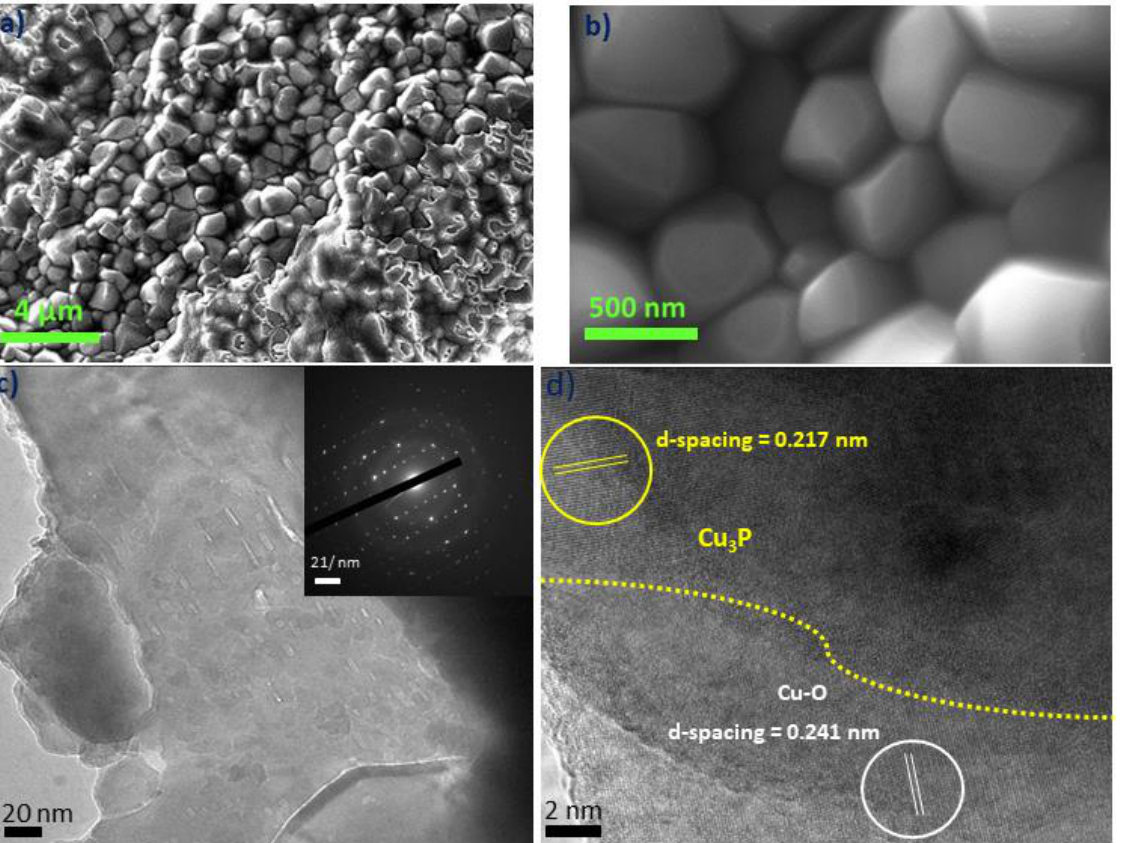
Figure 3 . HR-SEM of the formed heterostructure: ( a ) low-resolution image, ( b ) high-resolution image; ( c ) HR-TEM image of Cu-O|Cu 3 P (inset; SAED pattern); and ( d ) lattice distance measurement from high-resolution image.